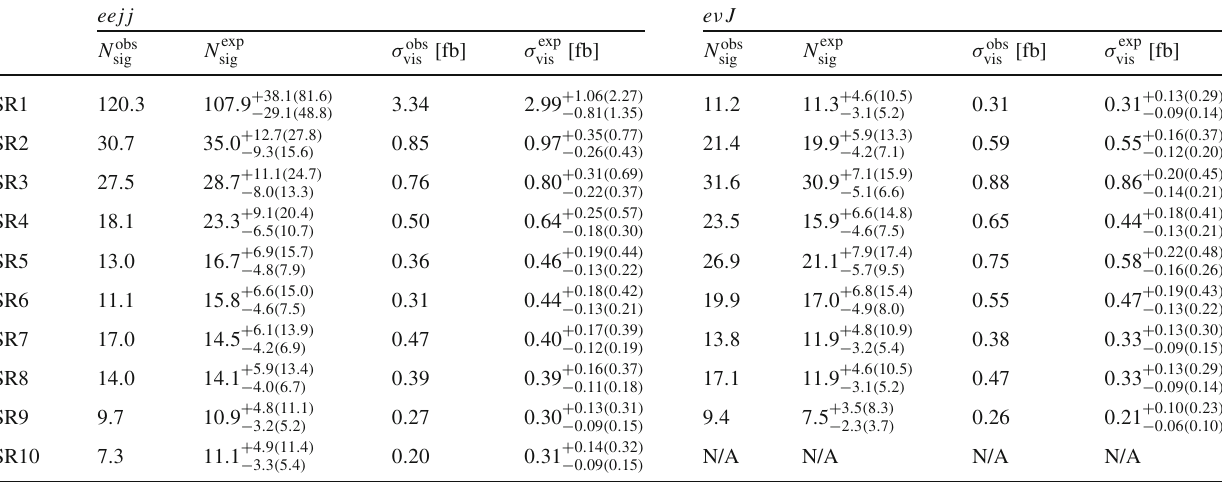
Table 11 Observed and expected model-independent limits at 95% uncertainty intervals around the expected limit represent all sources of CL on the number of signal events N sig and the visible cross section systematic and statistical uncertainties. The SR10 is not defined for the σ ν J channels. The ± 1 ( 2 )σ e ν J channel and denoted as “N/A” vis in the signal regions of the eejj and e e ν